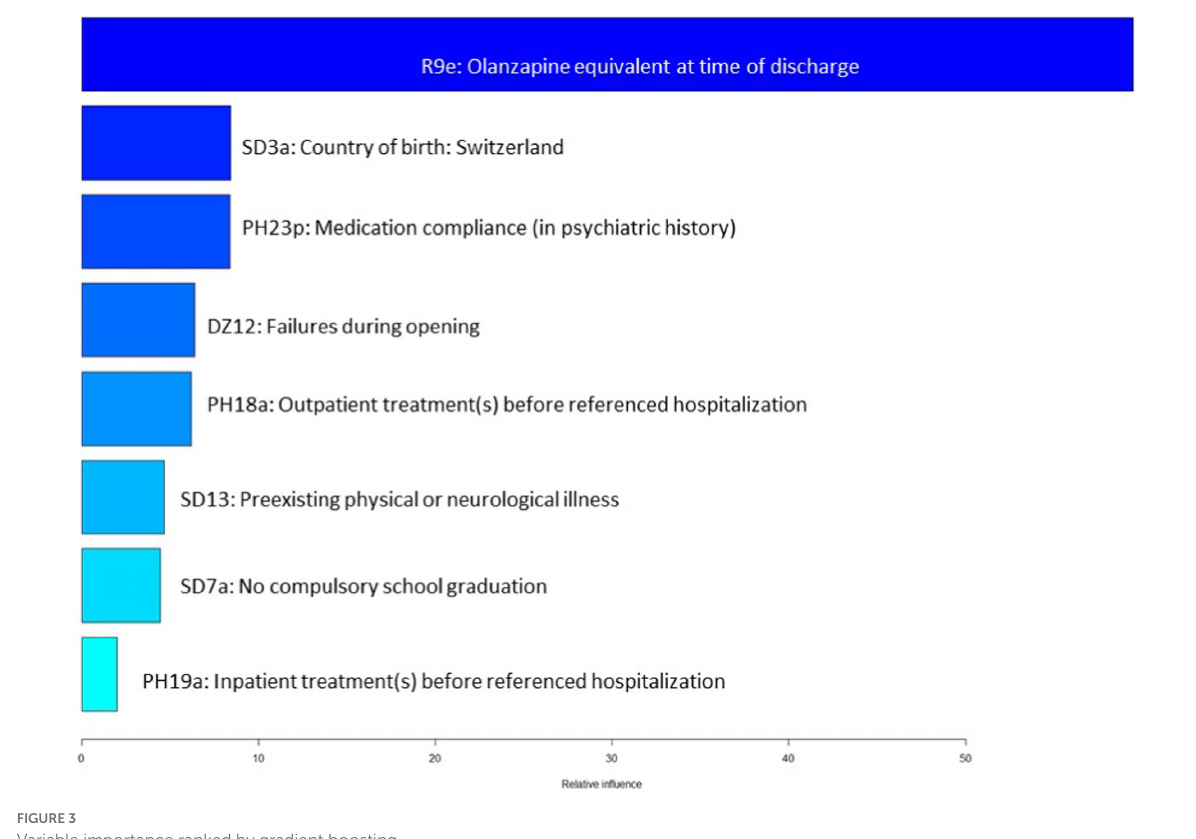
FIGURE 3 Variable importance ranked by gradient